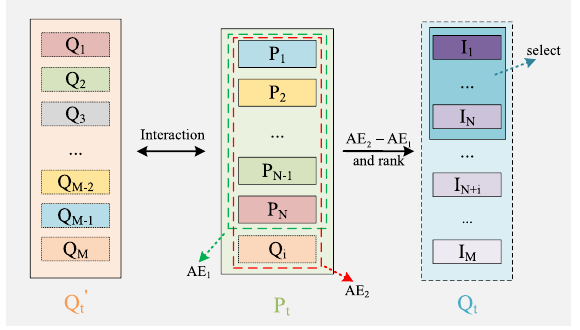
Fig. 5 Example of the proposed architecture entropy-based sampling strategy